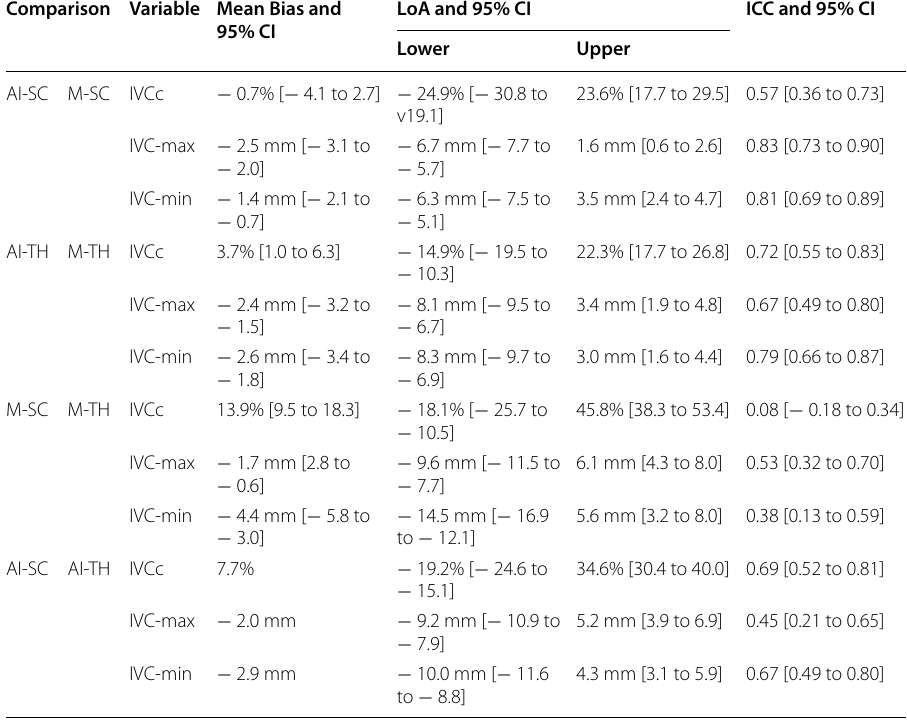
Table 2 Summary of comparisons made between measurement of the inferior vena cava (IVC) in healthy